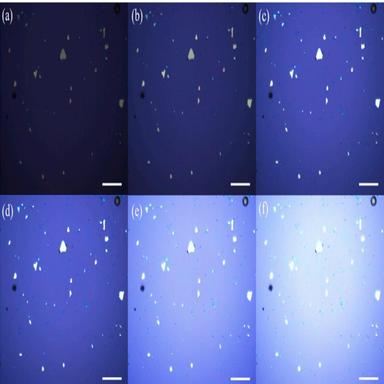
Optical image of samples in the same region at different light intensities (20 μm in scale). (a) Optical imaging at low light intensity, (b)-(d) optical imaging at appropriate light intensity, (e)-(f) optical imaging at high light intensity.